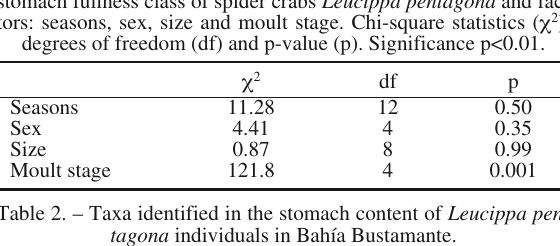
Table 2. – Taxa identified in the stomach content of Leucippa pen- tagona individuals in Bahía Bustamante. CYANOPHYTA